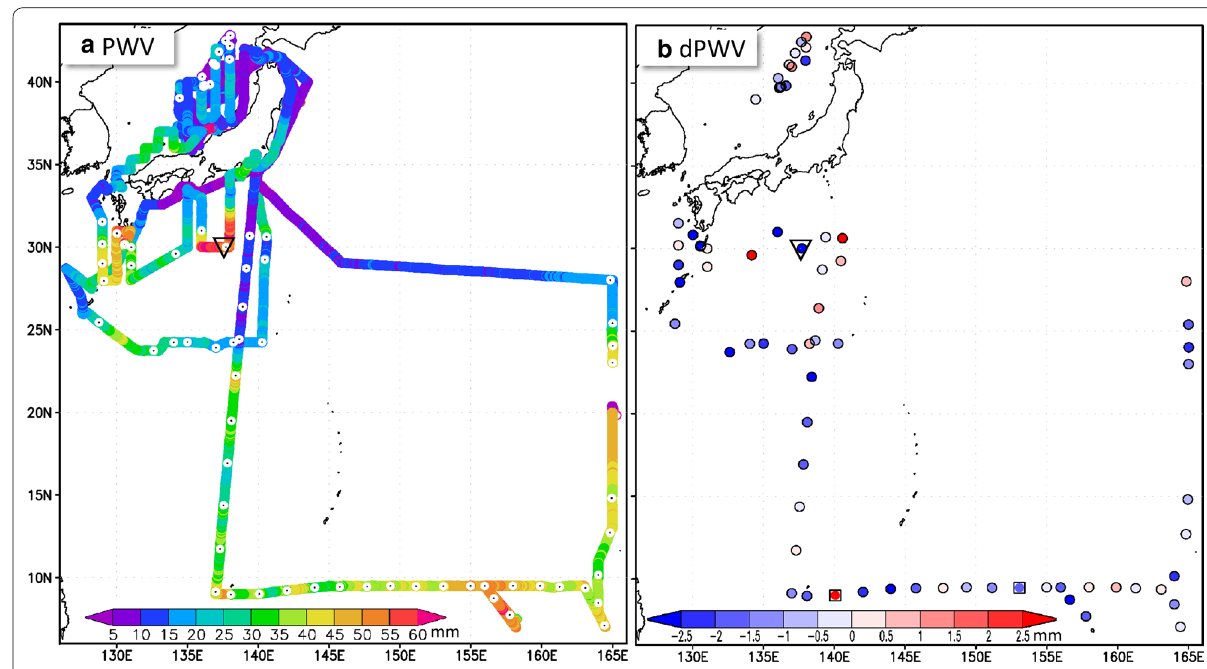
Fig. 5 a Estimated GNSS PWV from the MAST measurements along the RYOFU MARU trajectory. White circles represent the radiosonde launch locations. b Distribution of differences of GNSS PWV against radiosonde. Rejected data through the quality control are surrounded by black squares. An inverted triangle in each ( a ) and ( b ) indicates the area where a radiosonde launched at 2331UTC on June 10, 2017